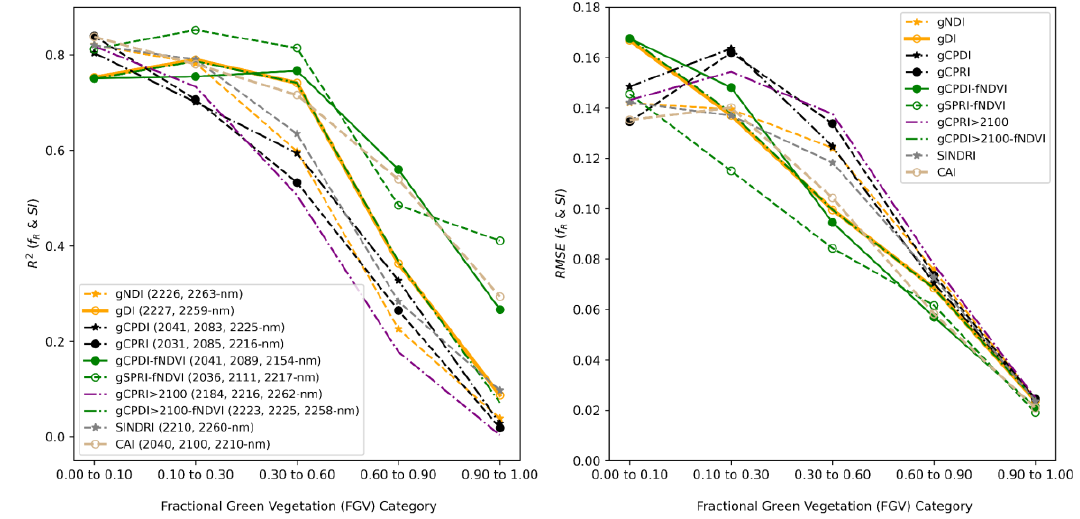
Figure 12. Wavelength shift spectral index (SI) f R estimation performance according to f GV (FGV) class, with heritage SINDRI and CAI for performance comparison. Left panel is R 2 and right panel is RMSE .